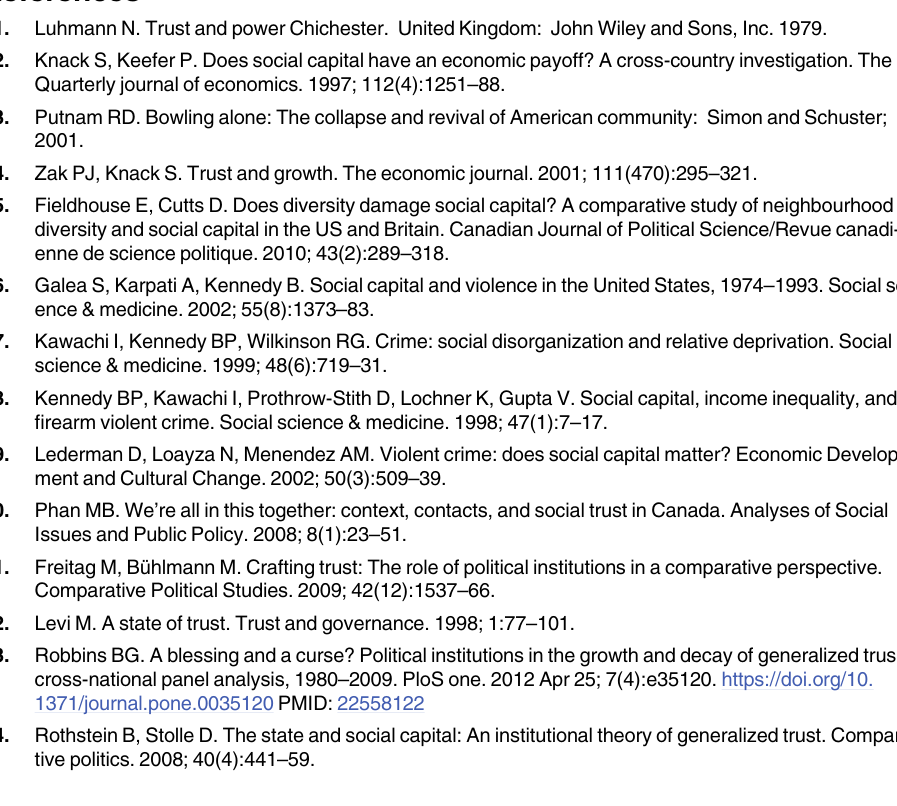
S1 File. Table A. CFA for institutional trust. Table B. CFA for pro-migrants attitudes. Table C. Descriptive statistics. Table D. MSEM with latent centering assessing mediation of institutional trust on the relationship between violent crimes and social trust. Table E. MSEM with latent centering assessing mediation of institutional trust on the relationship between property crimes and social trust. Table F. MSEM with latent centering assessing mediation of institu- tional trust on the relationship between impartiality and social trust. Table G. MSEM with latent centering assessing mediation of institutional trust on the relationship between corrup- tion and social